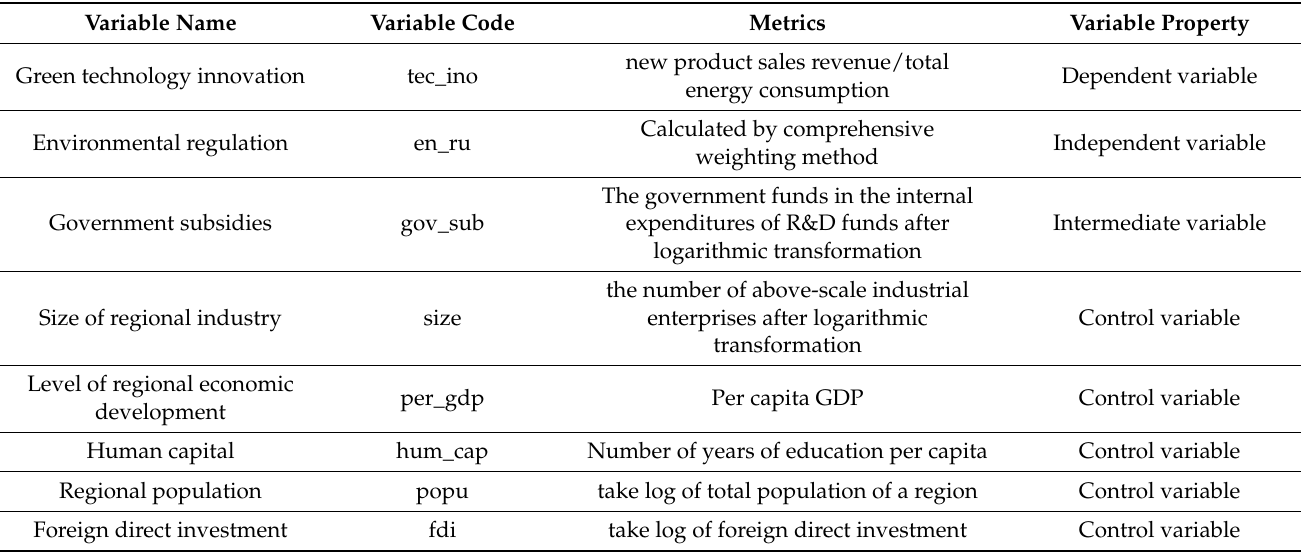
Table 2. Description of the